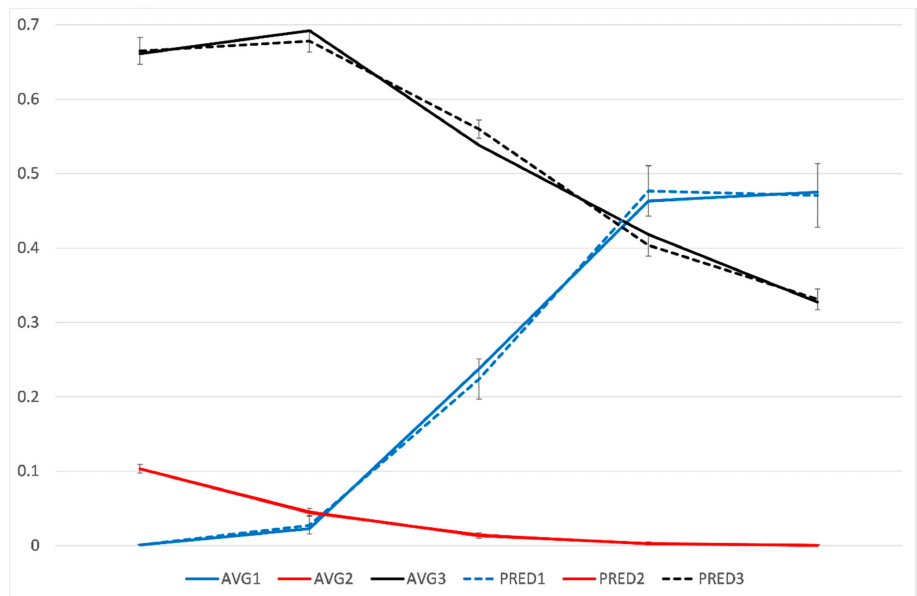
Figure 2. Unemployment trajectories during the follow-up (cohort entry year, 0, and a four-year follow-up) among individuals in the study population (autism spectrum disorder, ASD, 3.6%). AVG = average, PRED = predicted for each trajectory group. PRED1, PRED2, AND PRED3 (dashed lines) are the model estimates with their 95% confidence intervals for trajectory groups 1, 2, and 3, respectively. AVG2 and PRED2 overlap almost completely. Y axis: probability of unemployment; X -axis: follow-up years from